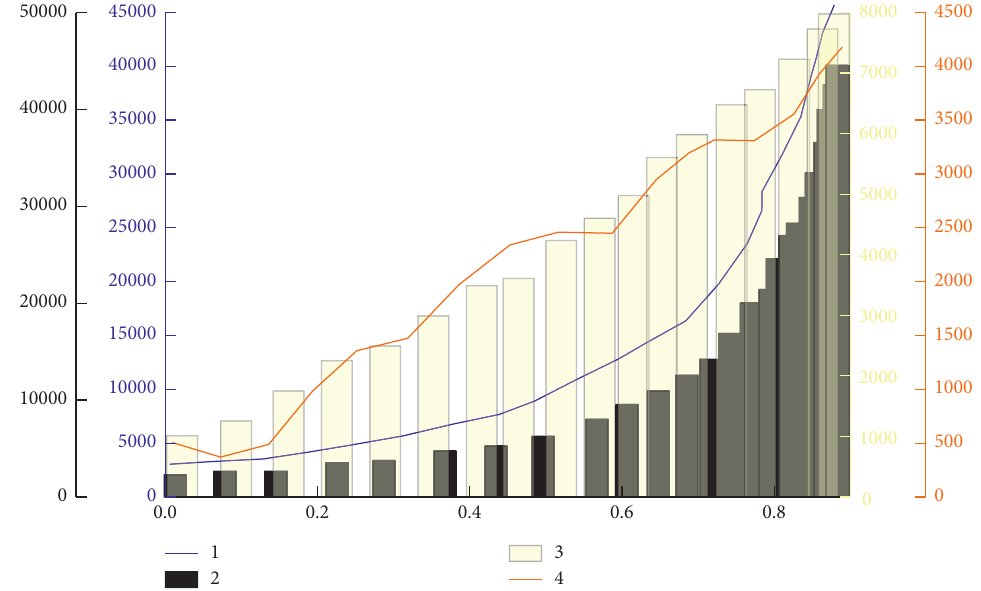
Figure 5: Influence of competition coefficient on optimal